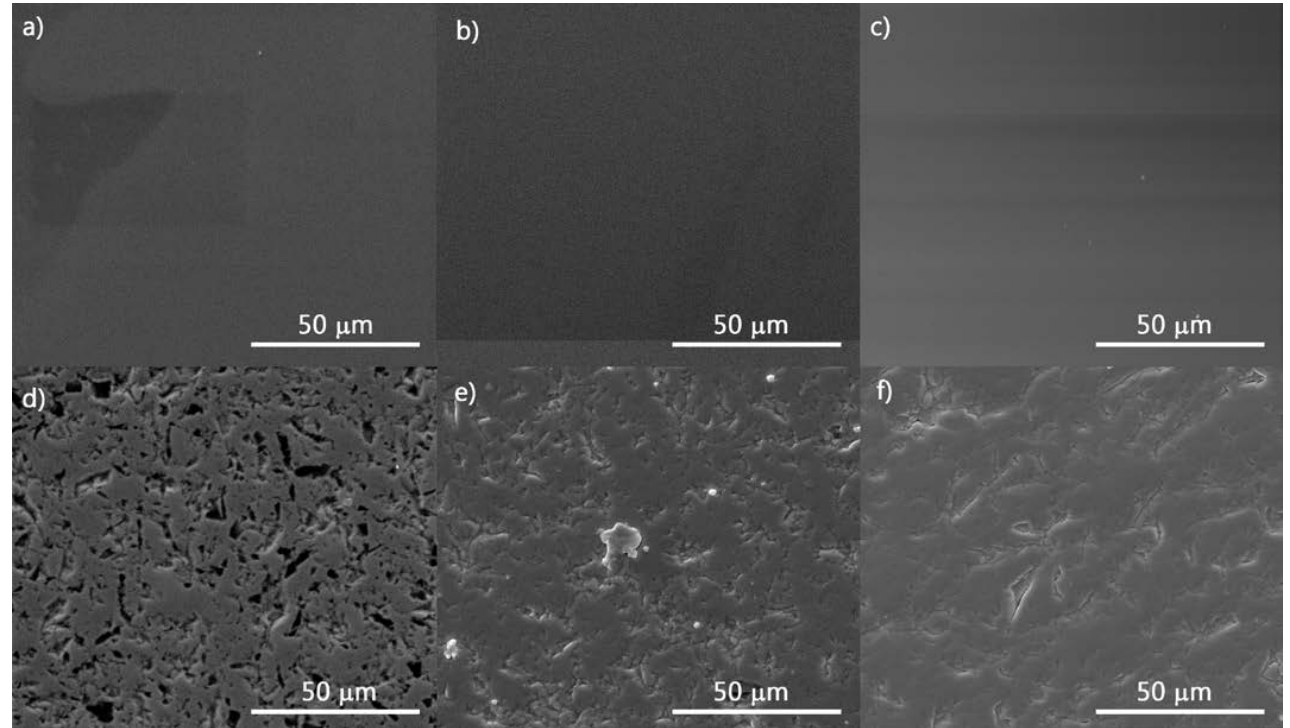
Figure 2. The caption below includes the code of the samples together with the abbreviated symbol for the substrate